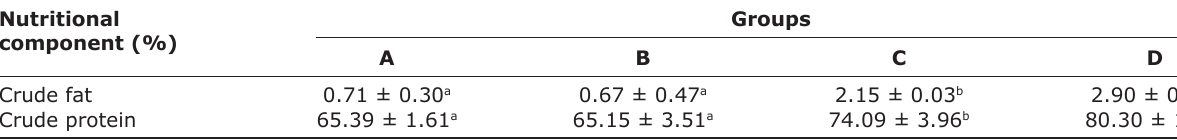
Table-4: Nutritional composition (%, DW) of fish fed with experimental diet. Nutritional component